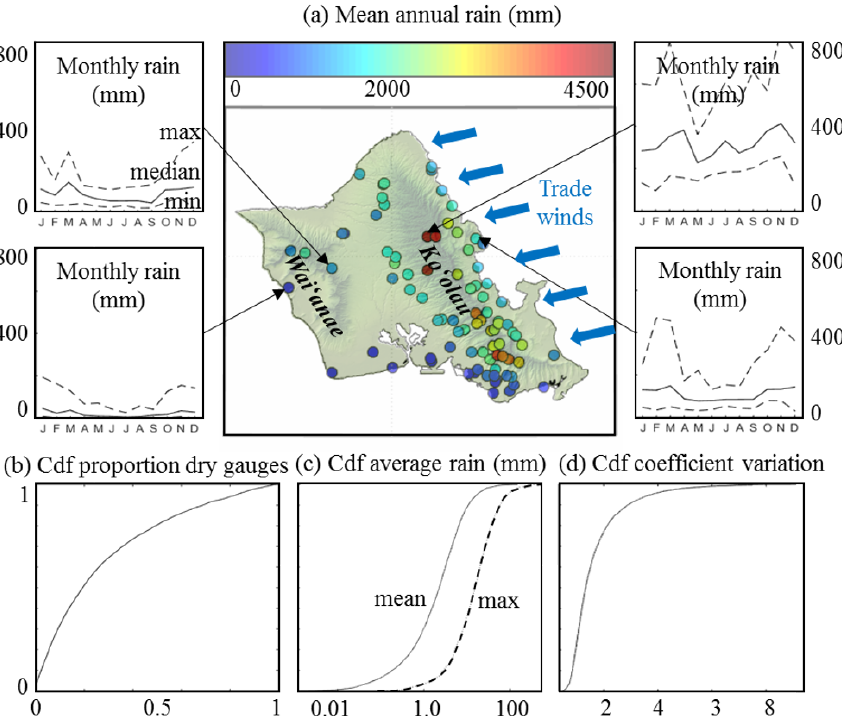
Figure 1. Main features of rainfall observed over the island of O‘ahu. (a) Mean annual rainfall (central panel) and seasonality of rain accumulation for four specific rain gauges (outer panels). (b) Cumulative distribution function (cdf) of the proportion of gauges measuring no rain for a given day. (c) Cdf of the mean and maximum daily rain accumulation computed over the whole observation network (abscissa is in log scale). (d) Cdf of the coefficient of variation (i.e., standard deviation/mean) of daily rain accumulation throughout the rain gauge